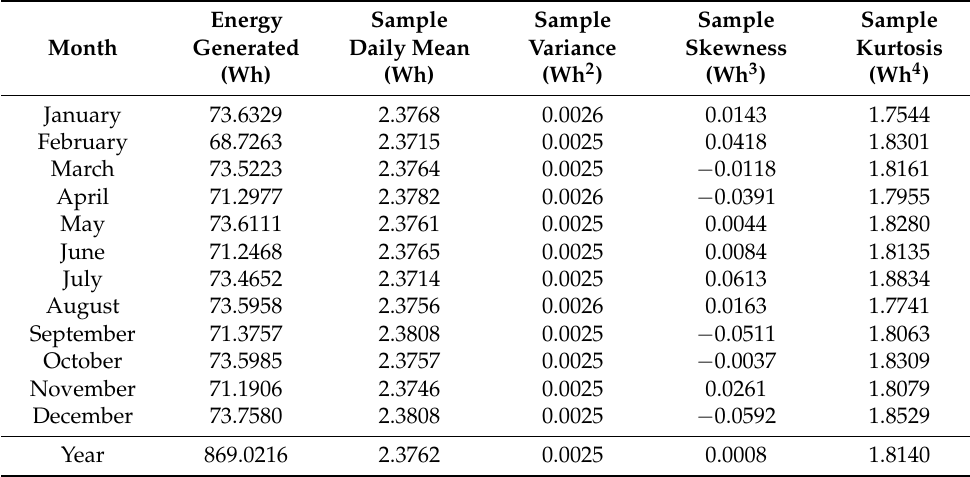
Table 12. Descriptive statistics of the power THMDL consumption in year